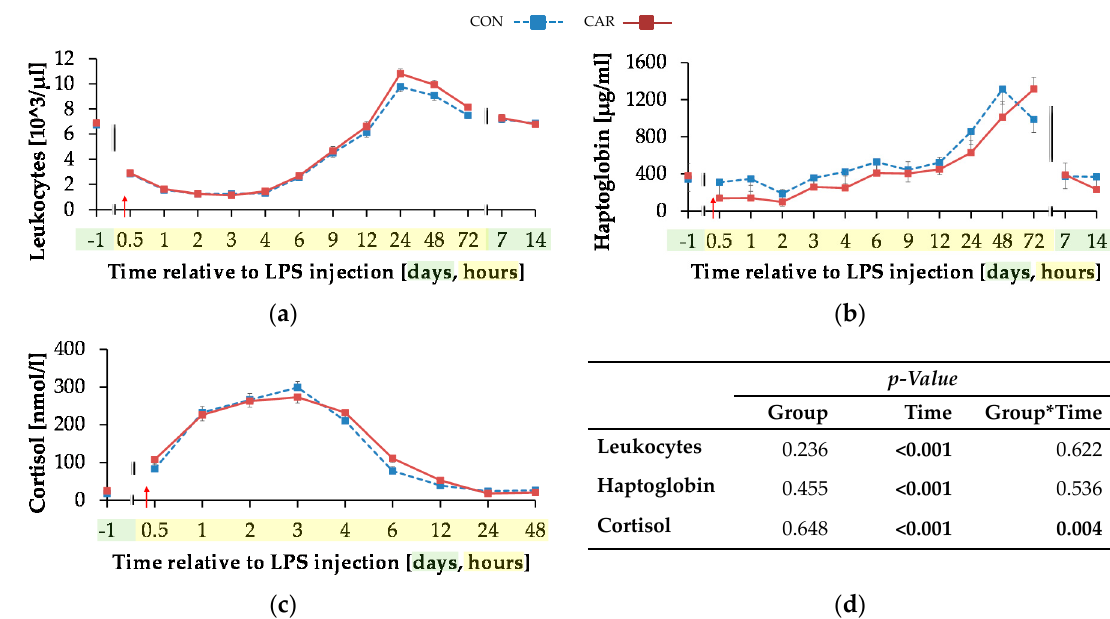
Figure 7. Progression of acute phase reaction related parameters of dairy cows fed a non-supplemented (CON) or an L-carnitine supplemented diet (CAR, 25 g/d from 6 weeks ap up to day 126 pp) before and after an intravenous injection of 0.5 μ g/kg BW lipopolysaccharides (LPS) on day 111 pp (red arrow). ( a ) Total leukocyte count, concentration of ( b ) haptoglobin and ( c ) cortisol. ( d ) Data statistics. Data are given as LS-Means standard errors. Significant p -values are marked as bold.